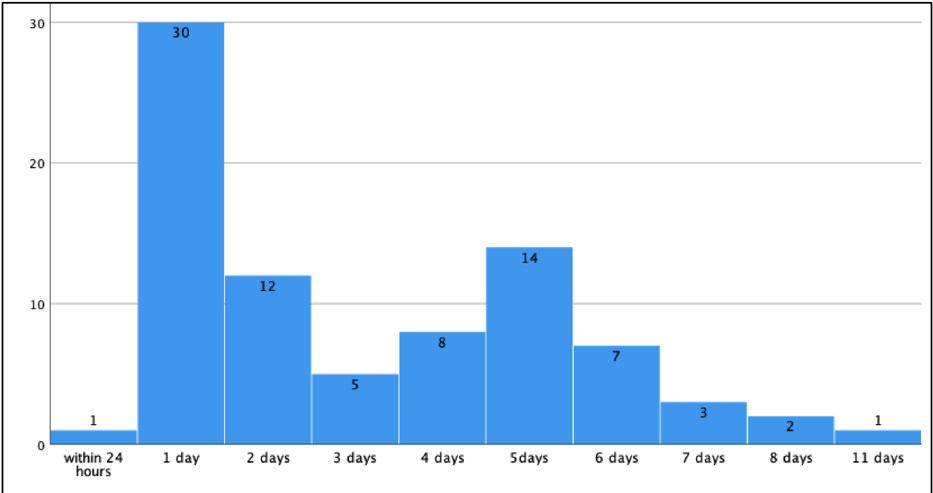
Figure 1. Timing of permanent pacemaker implantation (PPI) after transcatheter aortic valve replacement (TAVR). Table 3. Comparison of clinical parameters in patients with respect to PPI timing (48 h vs. later).